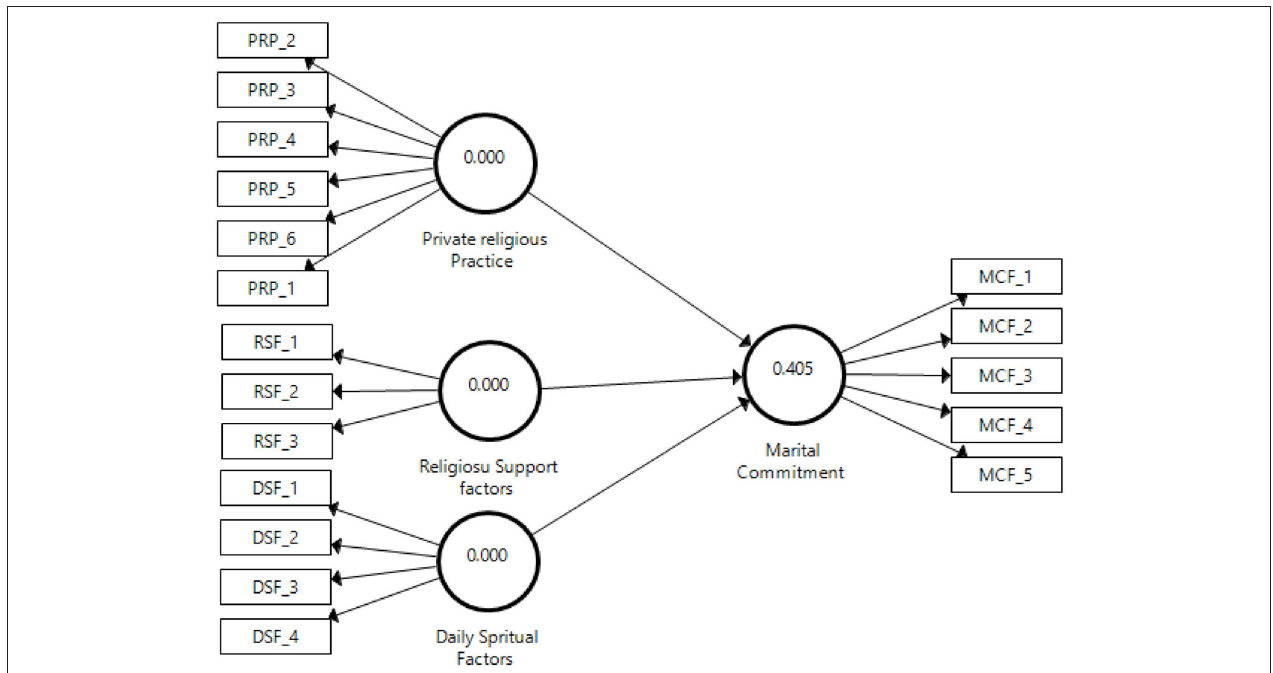
FIGURE 4 | The blindfolding